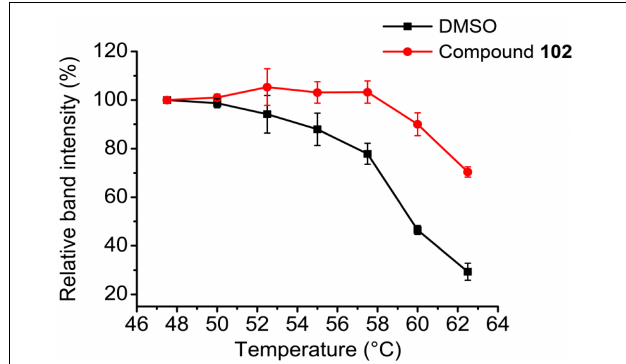
FIGURE 7 | CETSA melt curves. GPX4 protein amount comparison of compound 102 (250 µ M) and DMSO treated intact HEK293T cells after heated at different temperature. Data shown represent the mean ± standard error of mean (SEM; n = 3).